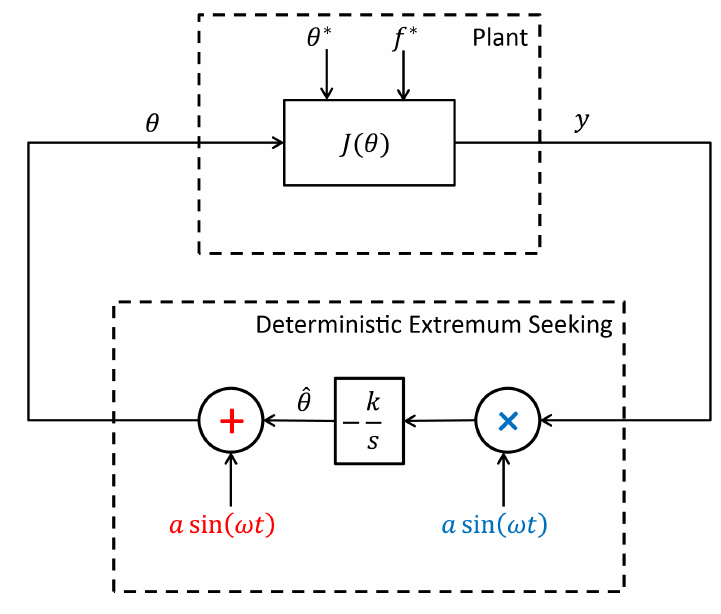
Figure 3 - Block diagram of deterministic ES for a static map using periodic perturbations. The simplest perturbation-based extremum seeking scheme for a ( θ − θ ∗ ) 2 , where f ∗ , f (cid:48)(cid:48) , θ ∗ are all quadratic single-input map J ( θ ) = f ∗ + f (cid:48)(cid:48) 2 unknown. The user has to only know the sign of f (cid:48)(cid:48) ( > 0 ) , namely, whether the quadratic map has a minimum, and has to choose the adaptation gain k such that sgn ( − k ) = − sgn ( f (cid:48)(cid:48) ) . The user has to also choose the frequency ω as relatively large compared to a , k , and f (cid:48)(cid:48) . Regarding the Laplace symbol s , with some abuse of notation, we mix the frequency and time domains for brevity and conceptual clarity, i.e., the integrator transfer function k / s in the block diagram should be understood as an operator on a time-domain